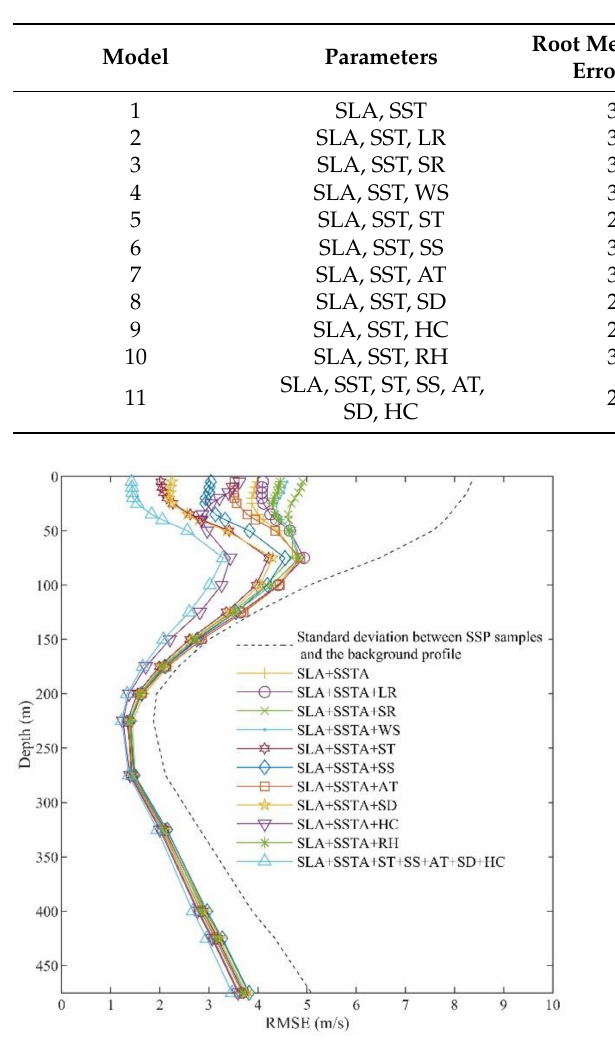
Table 1. Results of SSP estimation of each model.